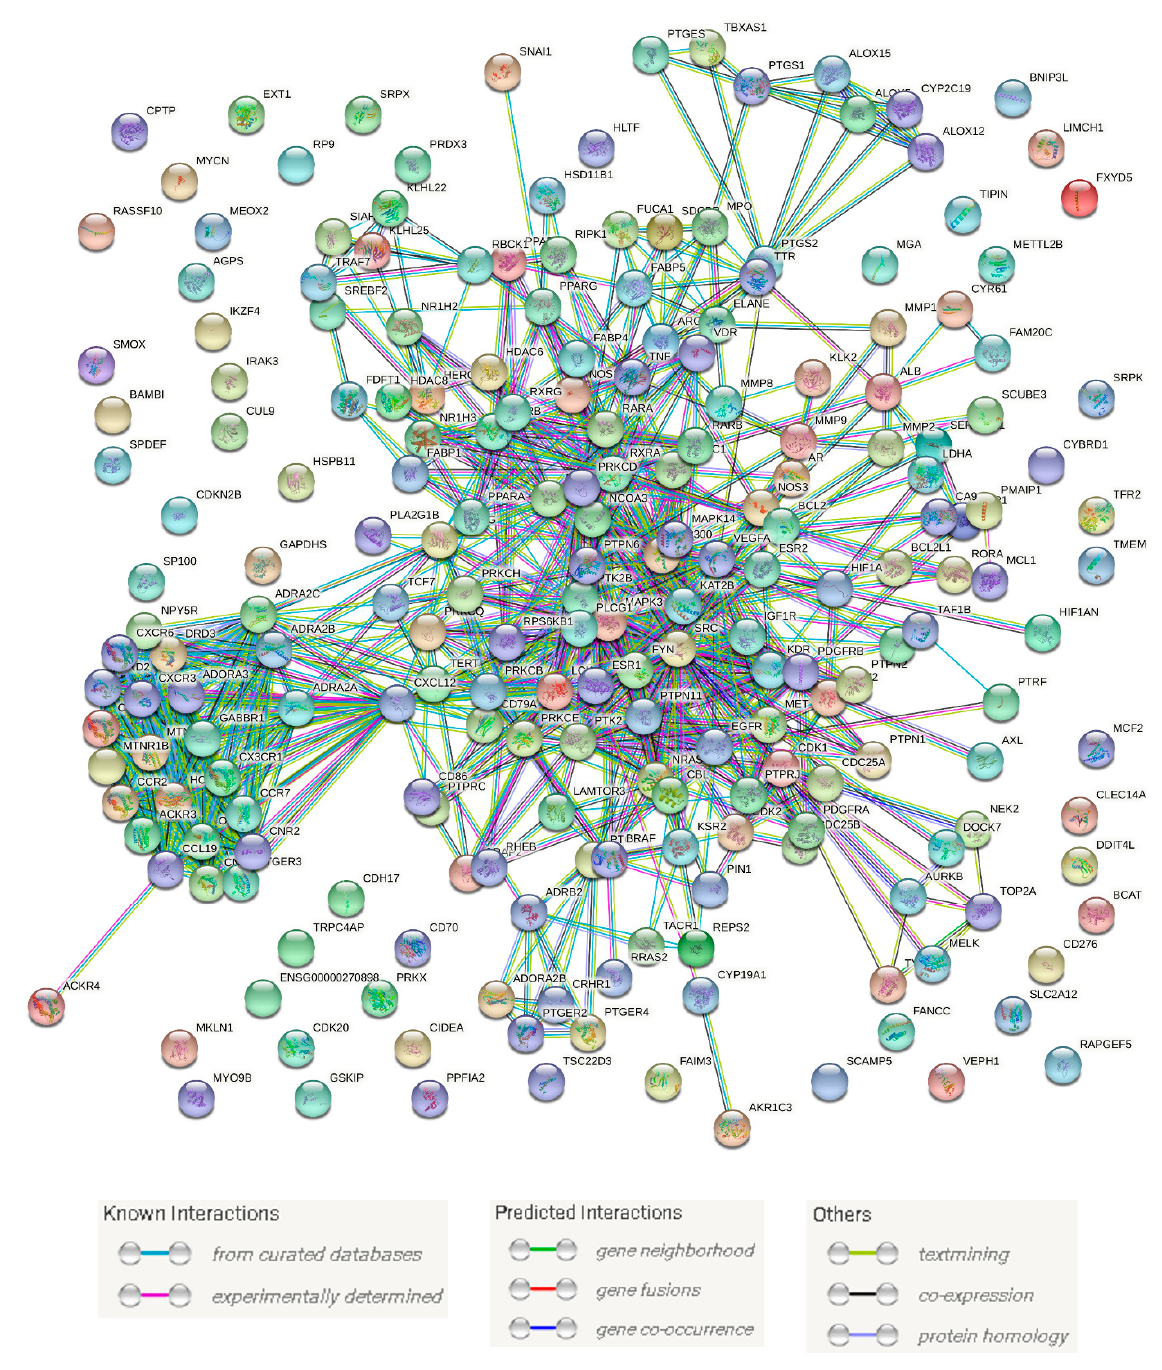
Figure 7. BC PPI network. This network consists of 214 nodes and 491 edges with an average node degree of 4.75.